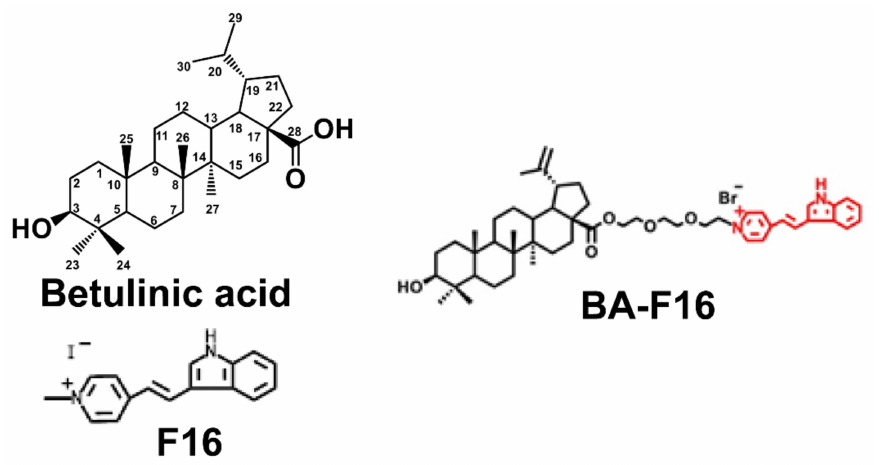
Figure 1. Structure of BA (BA), F16 (E-4-(1H-indol-3-ylvinyl)-N-methylpyridinium iodide]), and BA–F16 conjugate